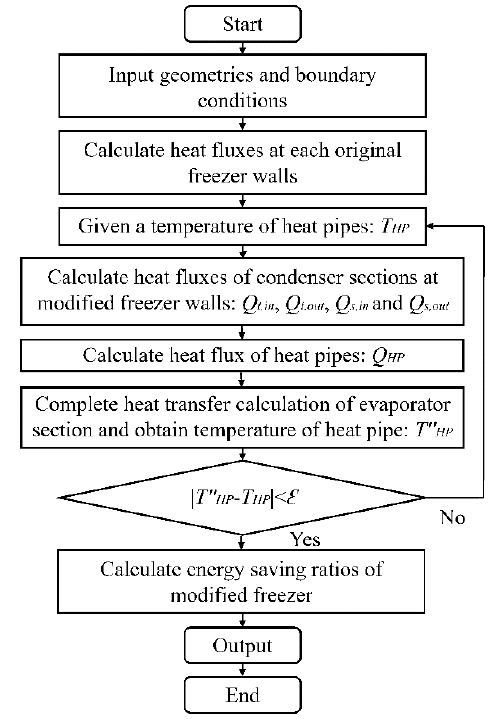
Figure 4. Computation algorithm for the improved refrigerator.